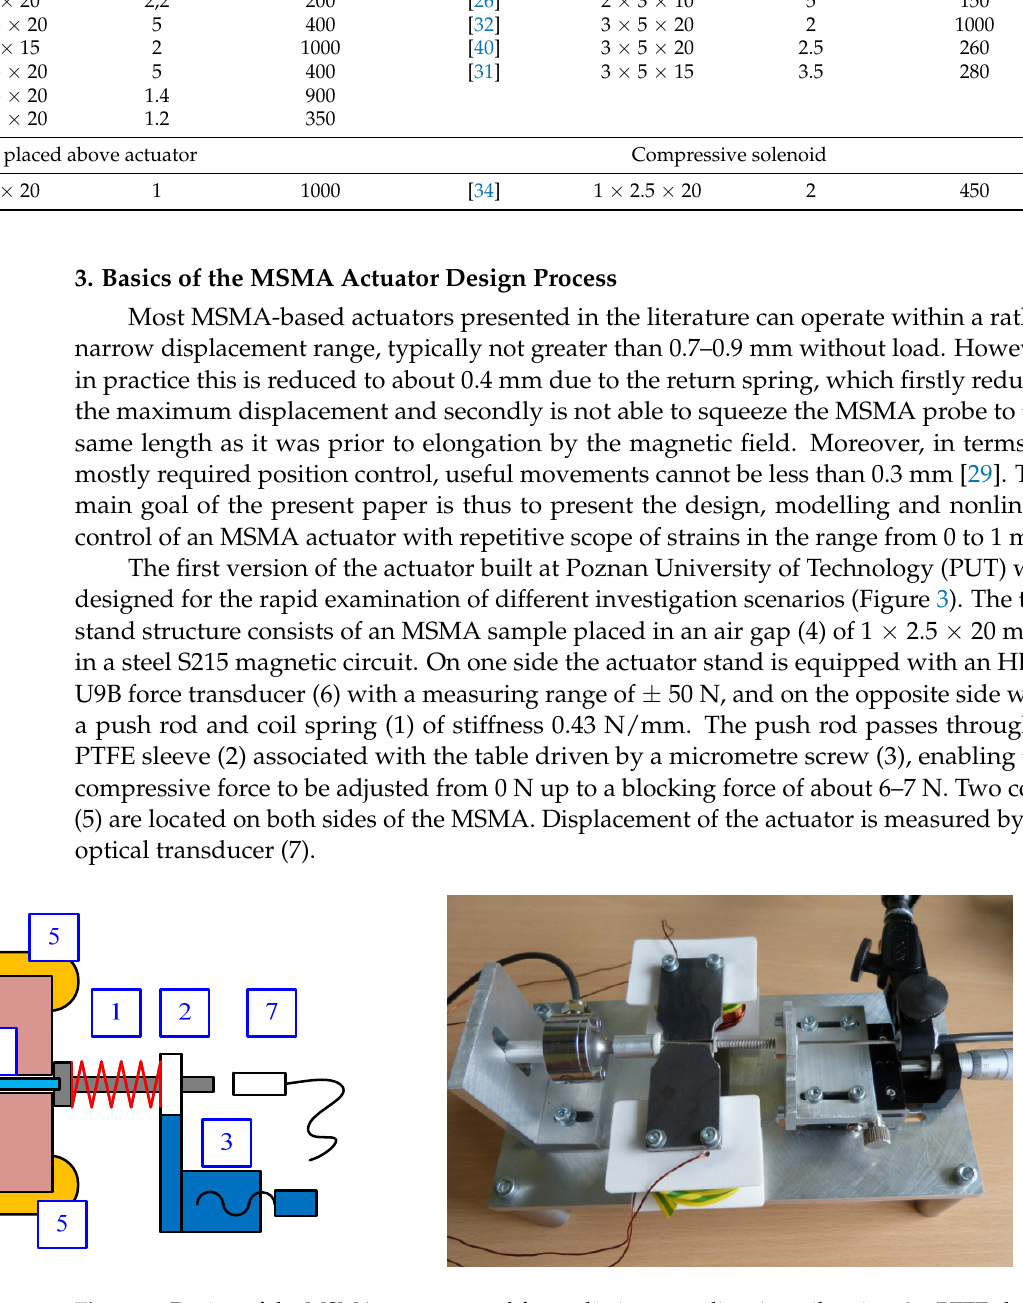
Figure 3. Design of the MSMA actuator used for preliminary studies: 1—coil spring, 2—PTFE sleeve, 3—table, 4—air gap with MSMA, 5—coils, 6—force transducer, 7—displacement transducer.